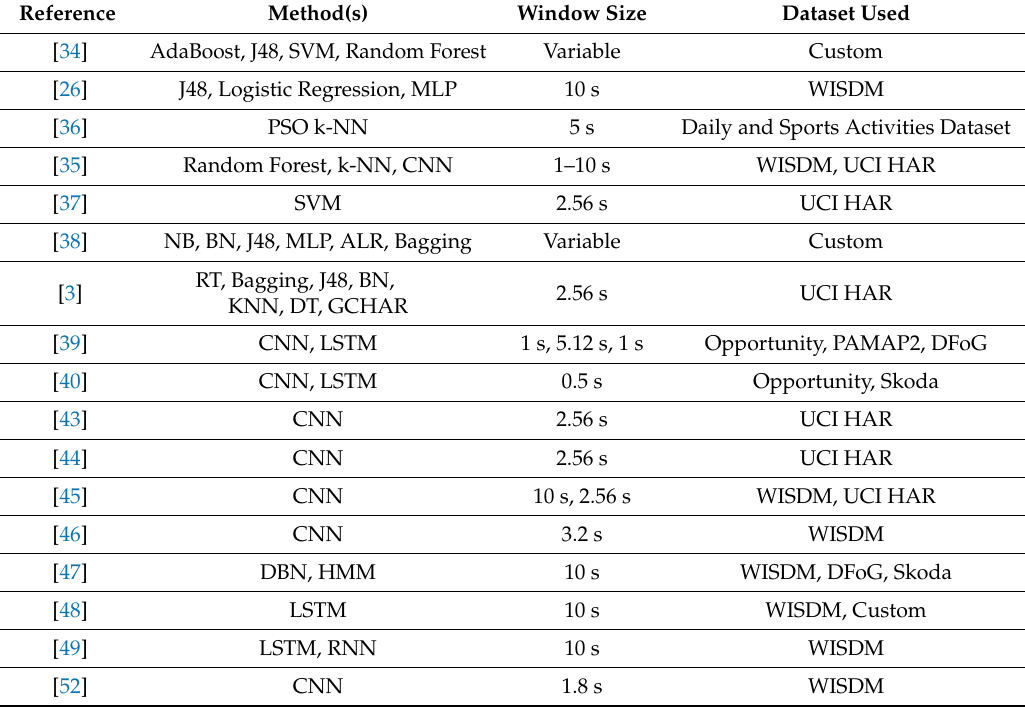
Table 1. Summarization